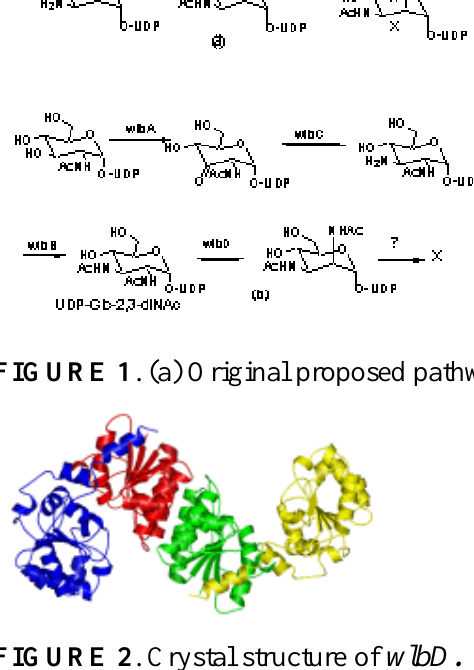
FIGURE 2 . Crystal structure of